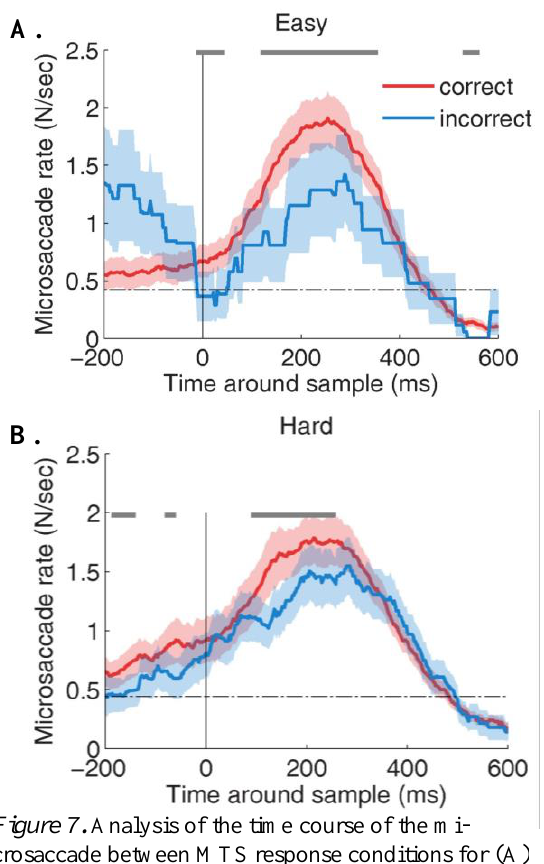
Figure 7. Analysis of the time course of the mi- crosaccade between MTS response conditions for (A) easy MTS task and (B) hard MTS task. Gray line indicates significance for one-tailed paired t-tests using Bonferroni Correction. α= 0.01. Shaded areas indicate S.E.M. across subjects.